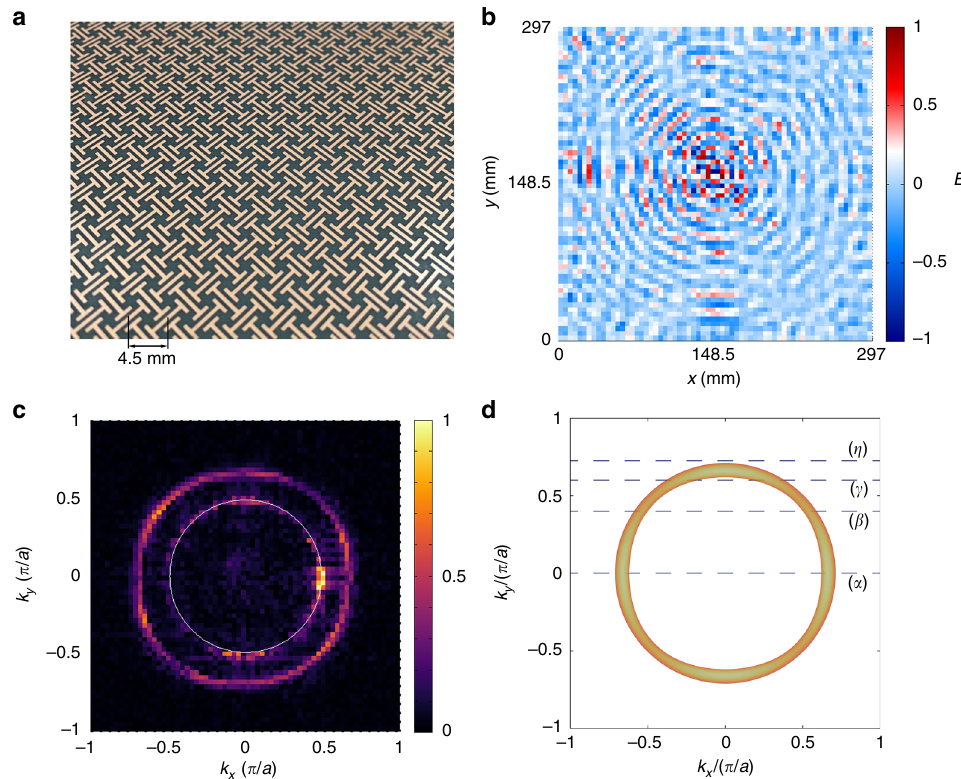
Fig. 2 The measured and simulated equi-frequency contours. a The metacrystal is fabricated by the standard single layer printed circuit board technique. There are 66 unit cells in the lateral x - and y- direction and 30 in the z -direction, with each unit cell having a size 4.5 × 4.5 × 2 mm 3 . b The measured distribution of the real part of the measured E z component (normalized to the maximum value) on the top surface of the metacrystal at 16.325 GHz. The source antenna is located at the center of the bottom surface. c Fourier transformed result of b exhibits a ring-shaped distribution. The thin white ring inside corresponds to the light cone. The Fourier components are normalized to the maximum. d Simulated EFS at 16.325 GHz. The dashed lines marked with ( α ) , ( β ) , ( γ ), and ( η ) denote four different cuts at k y = 0.01, 0.4, 0.6, and 0.725 π / a , fi nite width, which is consistent with the projection of a torus. For comparison, the numerically simulated EFS is given in Fig. 2d, which agrees reasonably well with the experimental result.